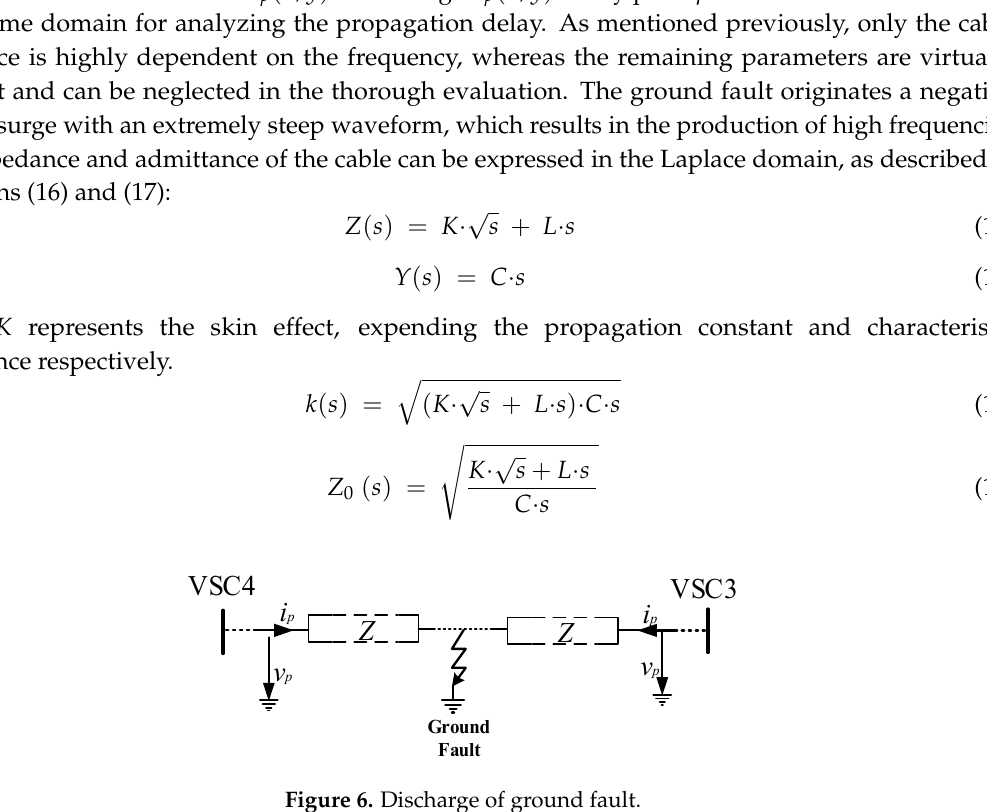
Figure 6. Discharge of ground fault.